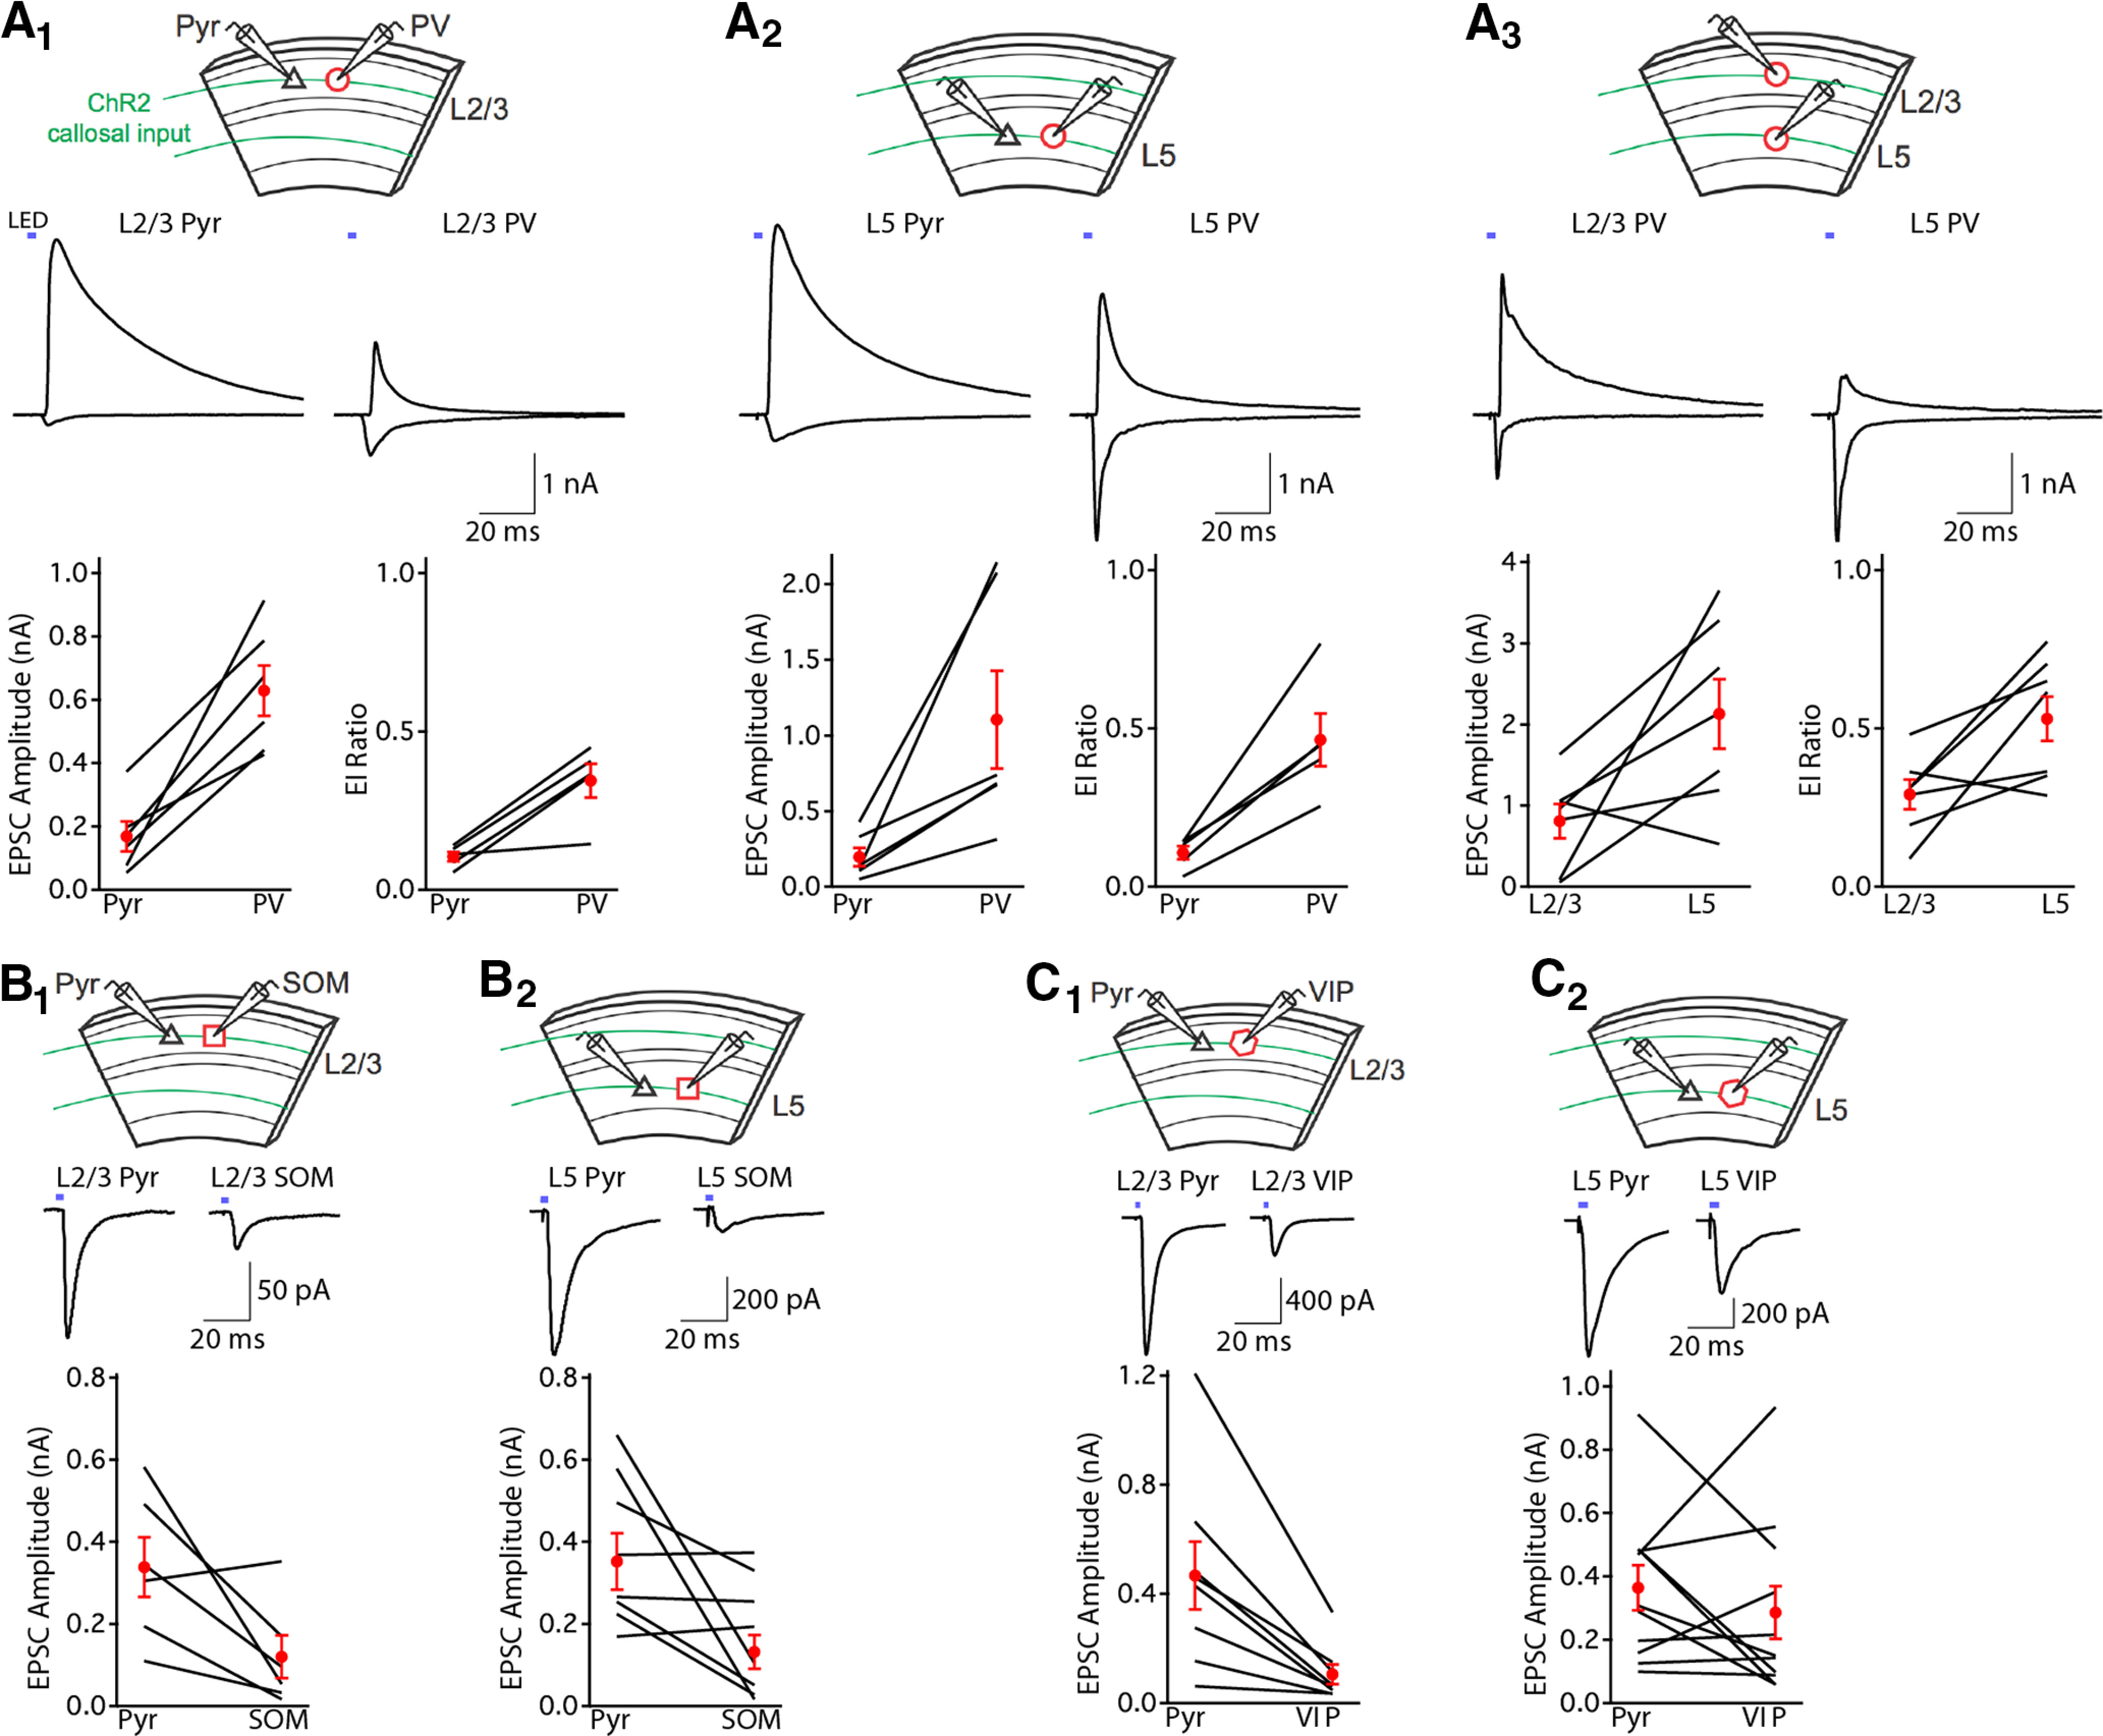
Cortical callosal inputs preferentially excite PV cells and drive strong feedforward inhibition. A1, L2/3 PV cells receive stronger callosal fiber-evoked EPSCs and have a larger E/I ratio than L2/3 pyramidal cells. Top, Recording configuration. Middle, Simultaneous voltage-clamp recording of L2/3 pyramidal cell (Pyr) and PV cell showing EPSCs (inward currents, −70 mV) and IPSCs (outward currents, +10 mV) evoked by brief LED illumination (blue bars) of ChR2-expressing callosal fibers. Bottom, Summary of EPSC peak amplitudes and E/I ratios for recorded pairs. Black lines, individual cell pairs. Red circles, mean ±SEM. A2, L5 PV cells receive stronger callosal fiber-evoked EPSCs and have a larger E/I ratio than L5 pyramidal cells. A3, L5 PV cells receive stronger callosal fiber-evoked EPSCs and have a larger E/I ratio than L2/3 PV cells. B, SOM cells in L2/3 (B1) and L5 (B2) receive weaker callosal fiber-evoked EPSCs than neighboring pyramidal cells. C, VIP cells in L2/3 (C1) receive weaker callosal fiber-evoked EPSCs than neighboring pyramidal cells. The strength of callosal input-evoked EPSCs in L5 VIP cells (C2) and pyramidal cells are similar.